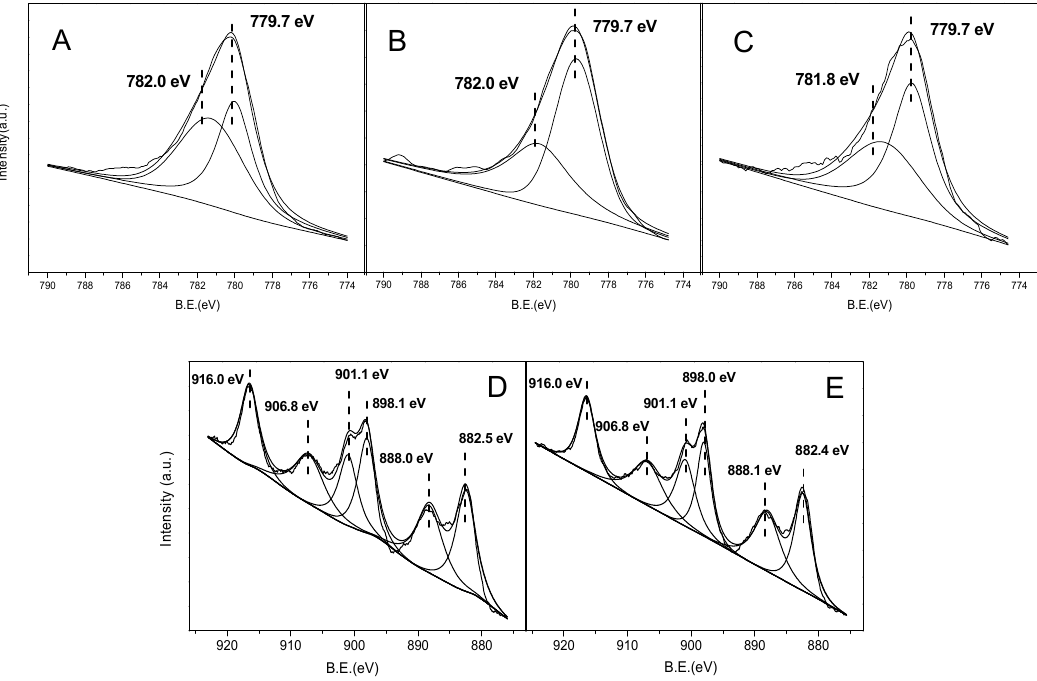
Figure 6. XPS of Co ‐ based catalysts: Co 2p of ( A ) Co 3 O 4 , ( B ) Co 3 O 4 ‐ CeO 2 , and ( C ) Co 3 O 4 ‐ CeO 2 ‐ 0.5; Ce 3d Figure 6. XPS of Co-based catalysts: Co 2p of ( A ) Co 3 O 4 , ( B ) Co 3 O 4 -CeO 2 , and ( C ) Co 3 O 4 - CeO 2 -0.5; of ( D ) Co 3 O 4 ‐ CeO 2 and ( E ) Co 3 O 4 ‐ CeO 2 ‐ 0.5. Ce 3d of ( D ) Co 3 O 4 -CeO 2 and ( E ) Co 3 O 4 -CeO 2